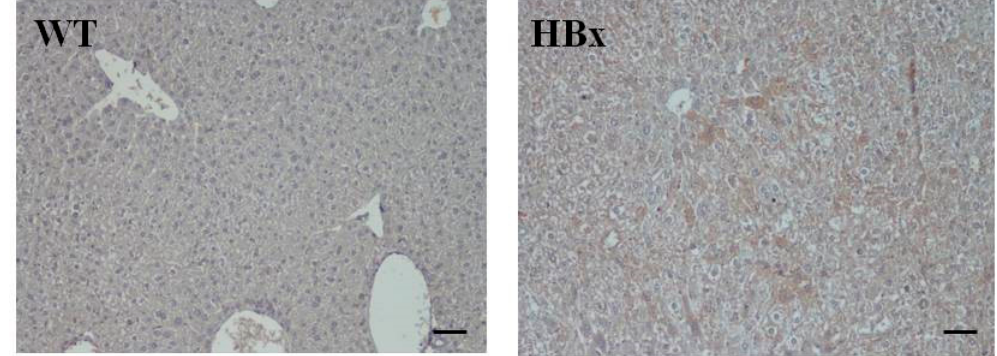
Figure 1. Immunohistochemistry (IHC) of mouse liver samples from wide type (WT) and hepatitis B virus X protein transgenic (HBx) mice. Samples were stained with antibodies of HBx. The scale bars indicate 30 μ m.